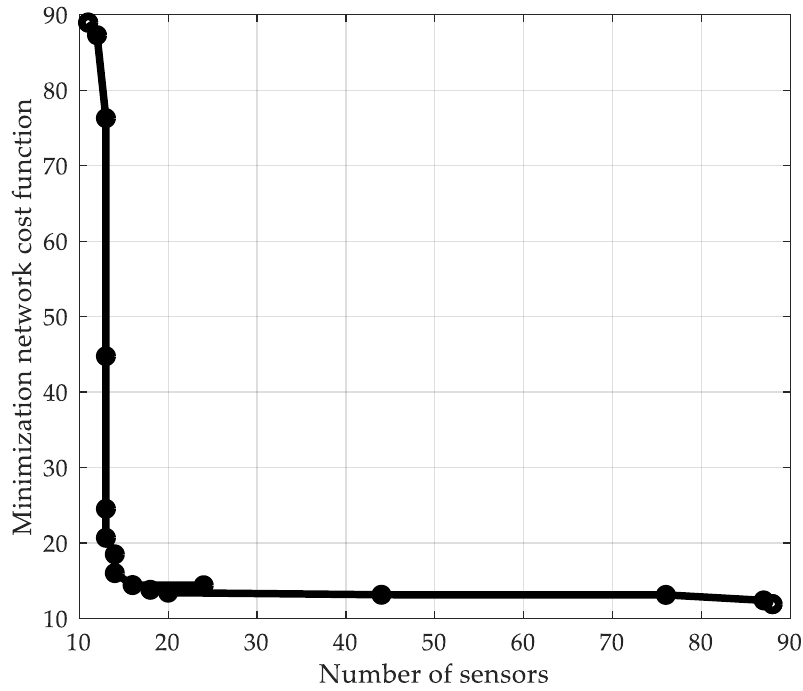
Figure 9. Number of sensors with coverage and minimization network cost value.